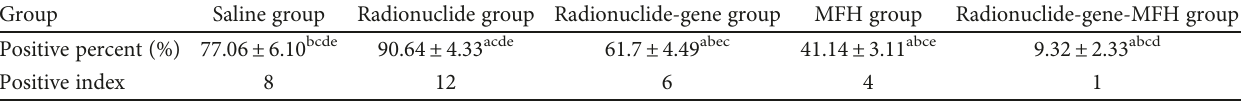
Table 7: VEGF protein expression of hepatoma tissues after di ff erent treatments tested by IHC (mean ± s, n = 5 ). Group Saline group Radionuclide group Radionuclide-gene group MFH